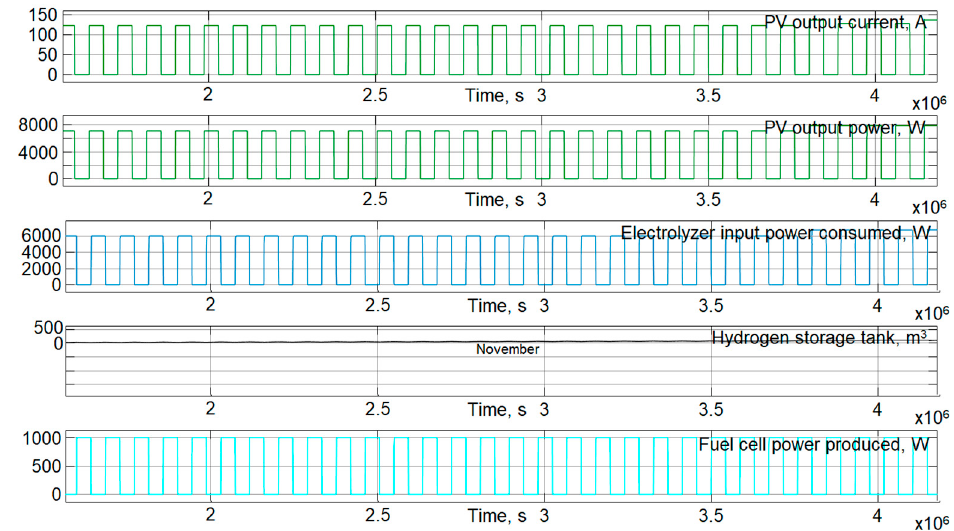
Figure 20. The result of the simulation and calculation of the required hydrogen tank capacity for the location Manipal, India (April only).